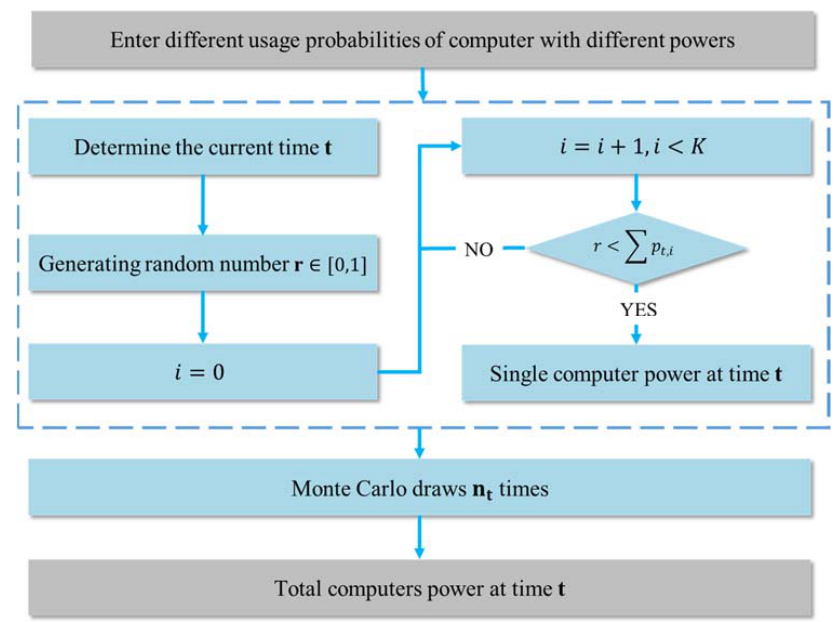
Figure 5. Computer instantaneous power value calculation process.